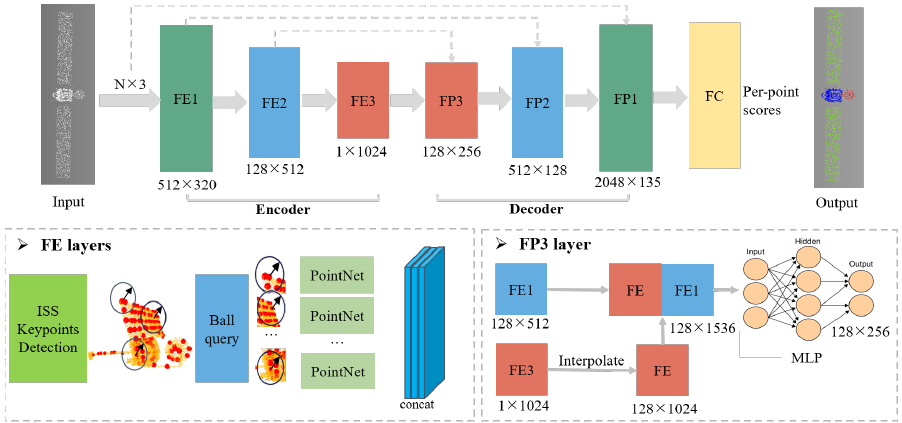
Figure 10. The architecture of the proposed